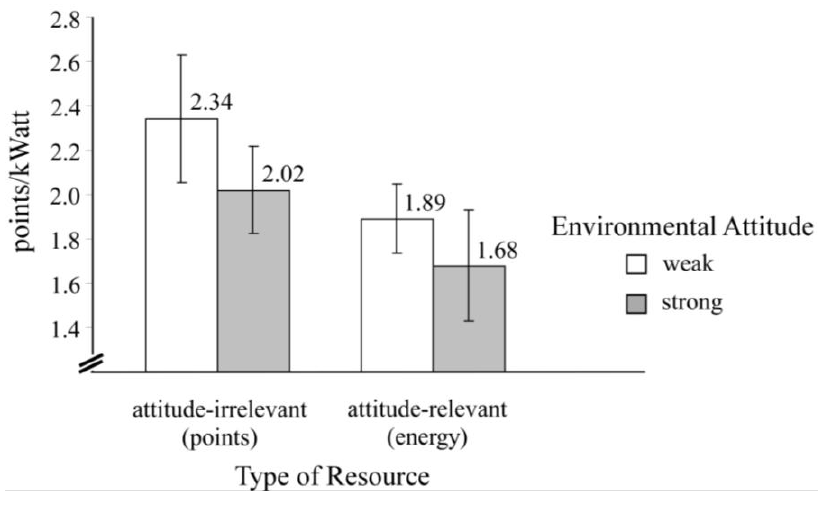
Figure 3 . Points/kWatt claimed as a function of people’s environmental attitude and of the attitudinal relevance of the common resource. Vertical bars indicate 95% confidence